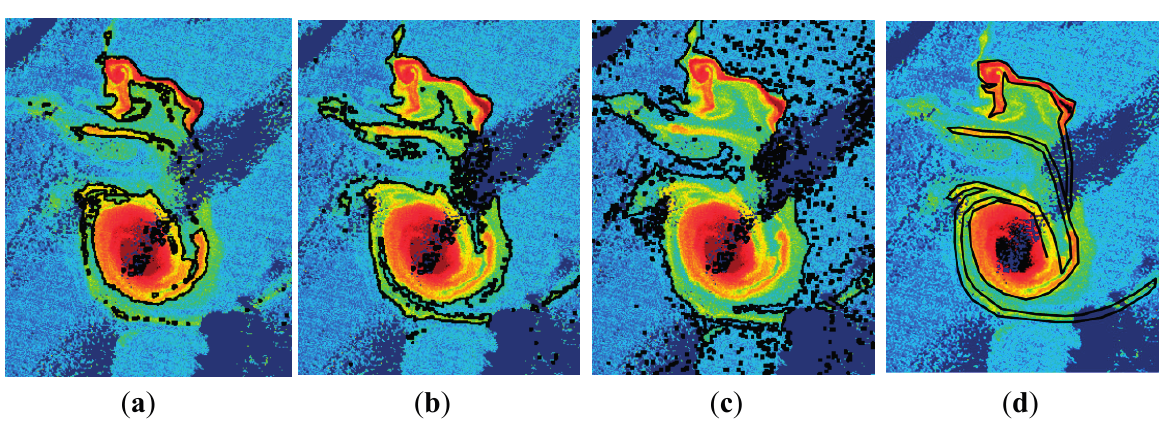
Figure 6. Structures detected by manual thresholding algorithms with global K d threshold values of: ( a – c ) 0.06, 0.05 and 0.04, respectively; ( d ) Segmentation desired by the